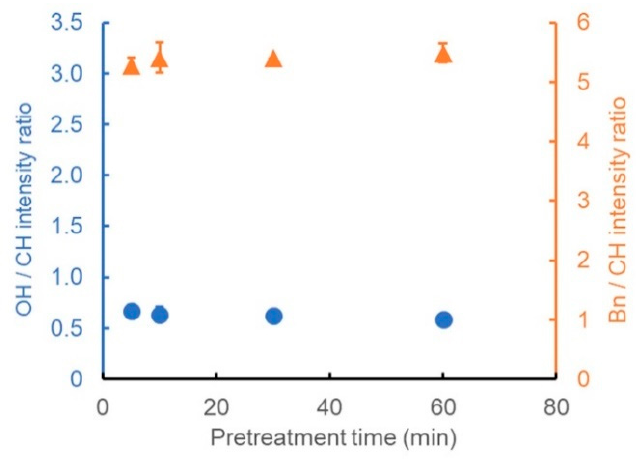
Figure 5. Ratio of the peak intensity derived from the OH groups (blue circles) or benzene rings (orange triangles) to that of CH stretching vibrations, showing the dependence of the degree of benzylation on the pretreatment time.